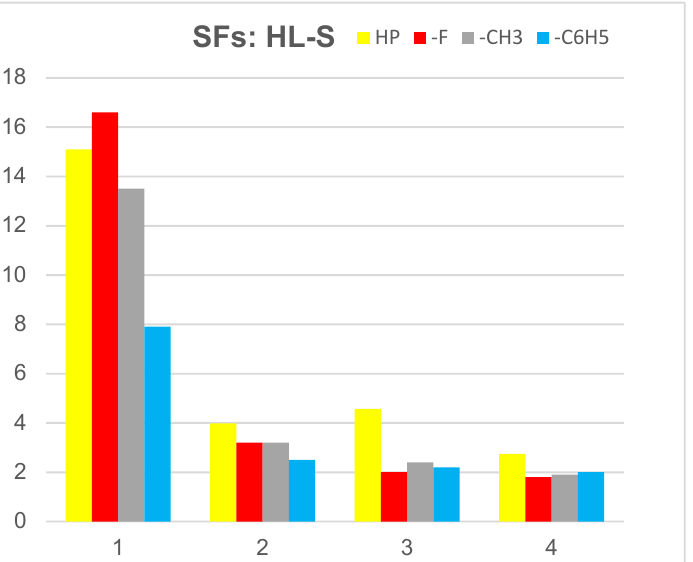
Figure 13. Comparison of the SFs calculated for synergistic mixtures of HL − S1, applying a different chelating agent, HL, in CHCl 3 : 1-Nd/La; 2-Eu/Nd; 3-Ho/Eu and 4-Lu/Ho.